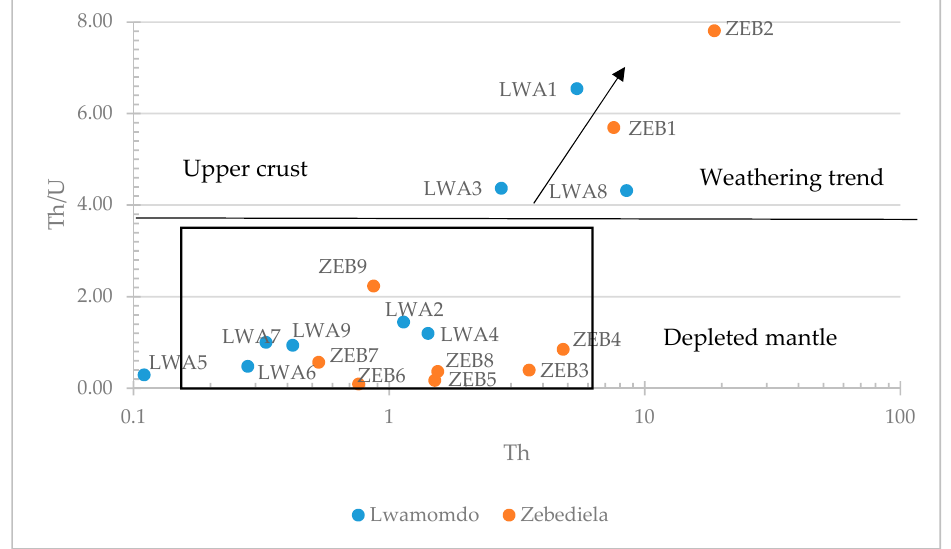
Figure 10. Plot of Th/U vs. Th for the Lwamondo and Zebediela kaolins, showing a mantle source.